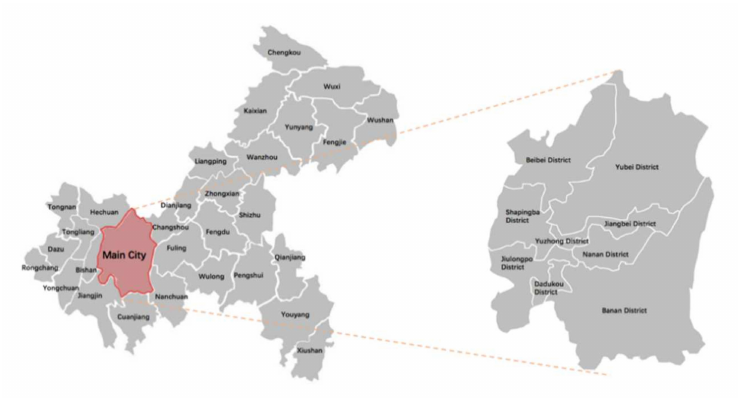
Figure 1. Map of